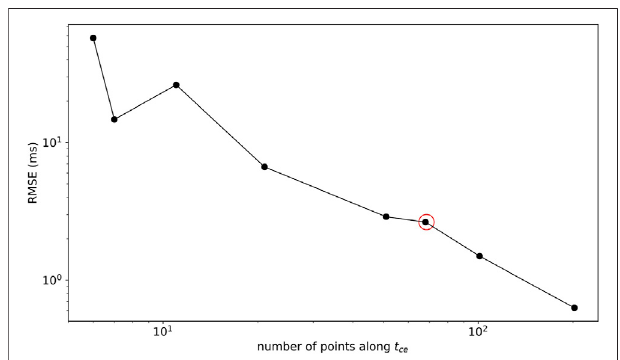
FIGURE A1 | Root-mean-square error (RMSE) as a function of the number of points along tce and ranging from 6 to 202. The red circle denotes RMSE corresponding to the boundary relationship computed in Section 3.1 (3.2